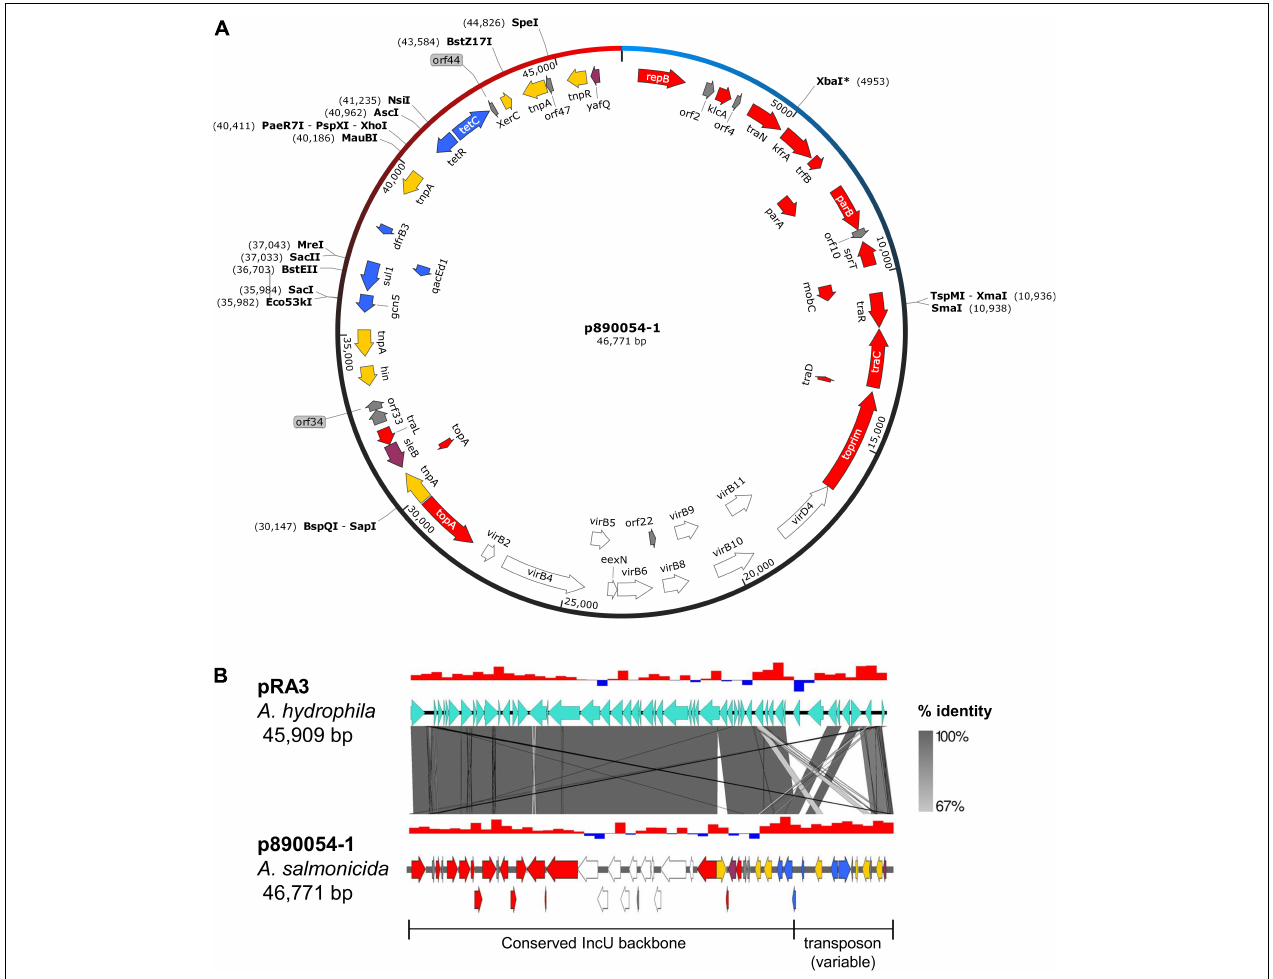
FIGURE 2 | Genetic map of p890054-1 (contig 4). (A) Circular map including coding DNA sequences (arrows) and unique restriction sites. Red arrows: conjugative transfer and partitioning genes. White arrows: Vir-like type IV secretion system genes. Yellow arrows: site-specific recombinases (transposase, resolvase, and invertase). Blue arrows: AMR genes. Purple arrows: Virulence and toxin/antitoxin genes. Gray arrows: genes encoding hypothetical proteins. (B) Pairwise alignment with pRA3 ( A. hydrophila ), a highly similar IncU family plasmid sharing the same mobility genes and Vir-like system gene cluster. Percentages indicate sequence identity while red/blue bars above sequences represent GC